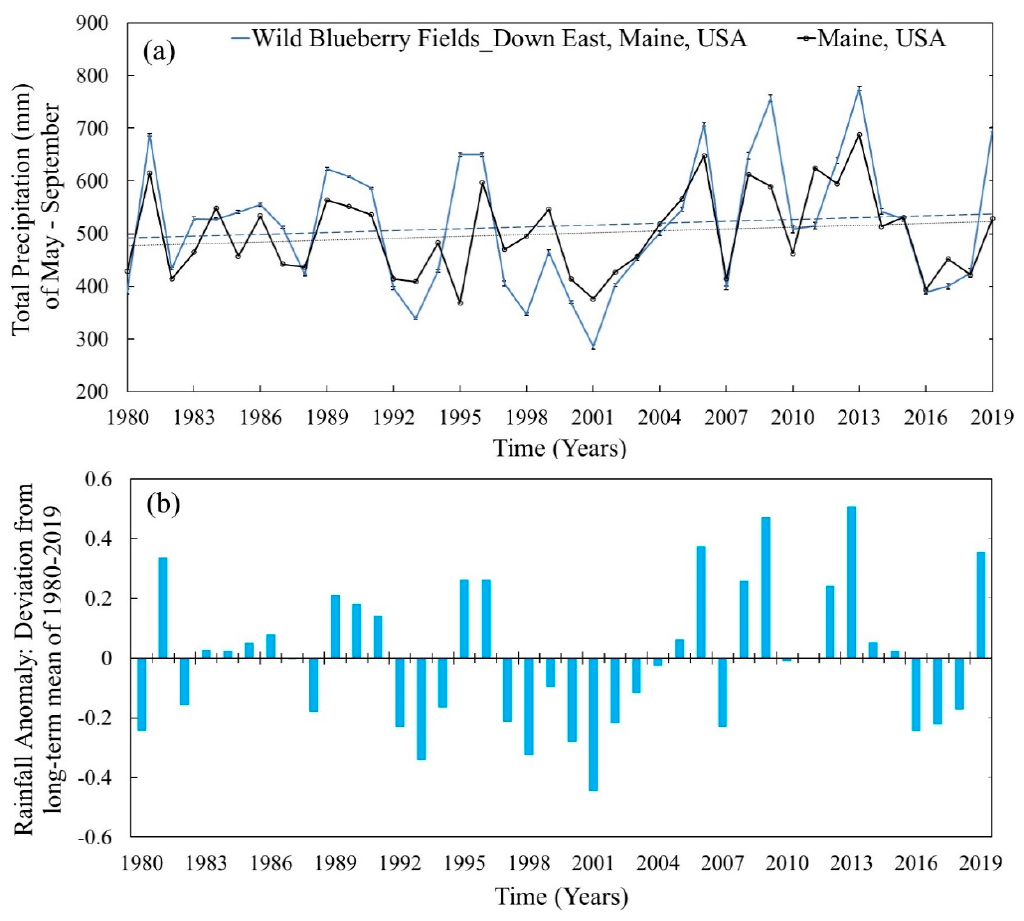
Figure 3. Changes in precipitation of the studied wild blueberry fields in the past 40 years. ( a ) Historical (1980 to 2019) changes in precipitation (total of May–September) throughout the state of Maine (averaged spatially), as well as at the 26 wild blueberry fields (shown in Figure 1) in Downeast, Maine. The climate variables from the fields are represented as the mean ± standard error (n = 26). The dotted lines are linear regression lines for the state of Maine and the dashed lines are the linear regression lines for the wild blueberry fields in Downeast, Maine over 40 years from 1980 to 2019. ( b ) Rainfall anomaly during 40 years from 1980 to 2019 (deviation in annual precipitation amounts from the long-term mean of 1980 to 2019) at the 26 wild blueberry fields (shown in Figure 1) in Downeast, Maine.